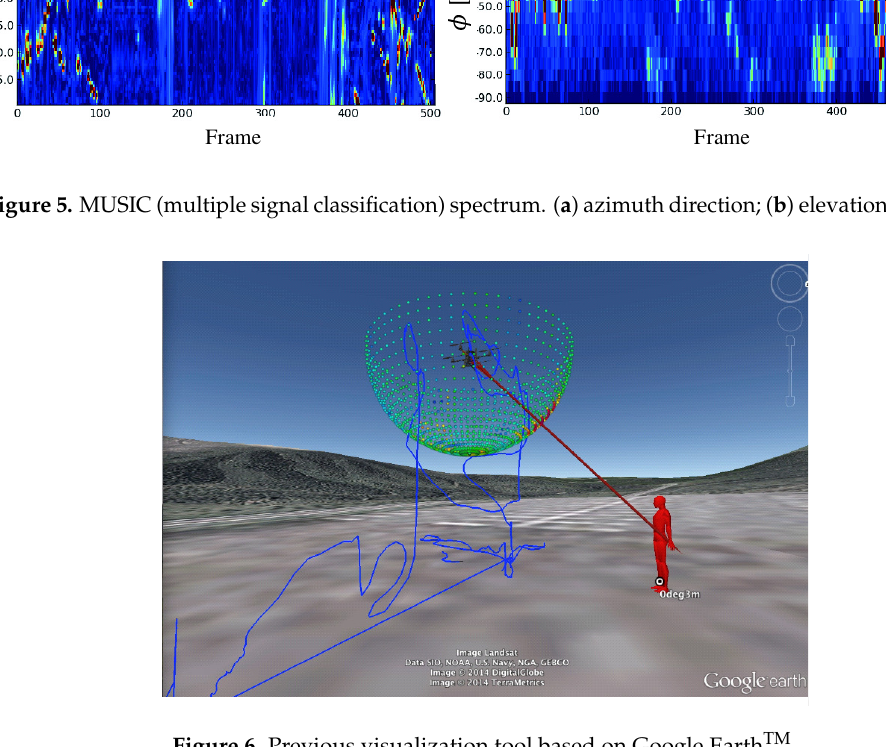
Figure 5. MUSIC (multiple signal classification) spectrum. ( a ) azimuth direction; ( b ) elevation